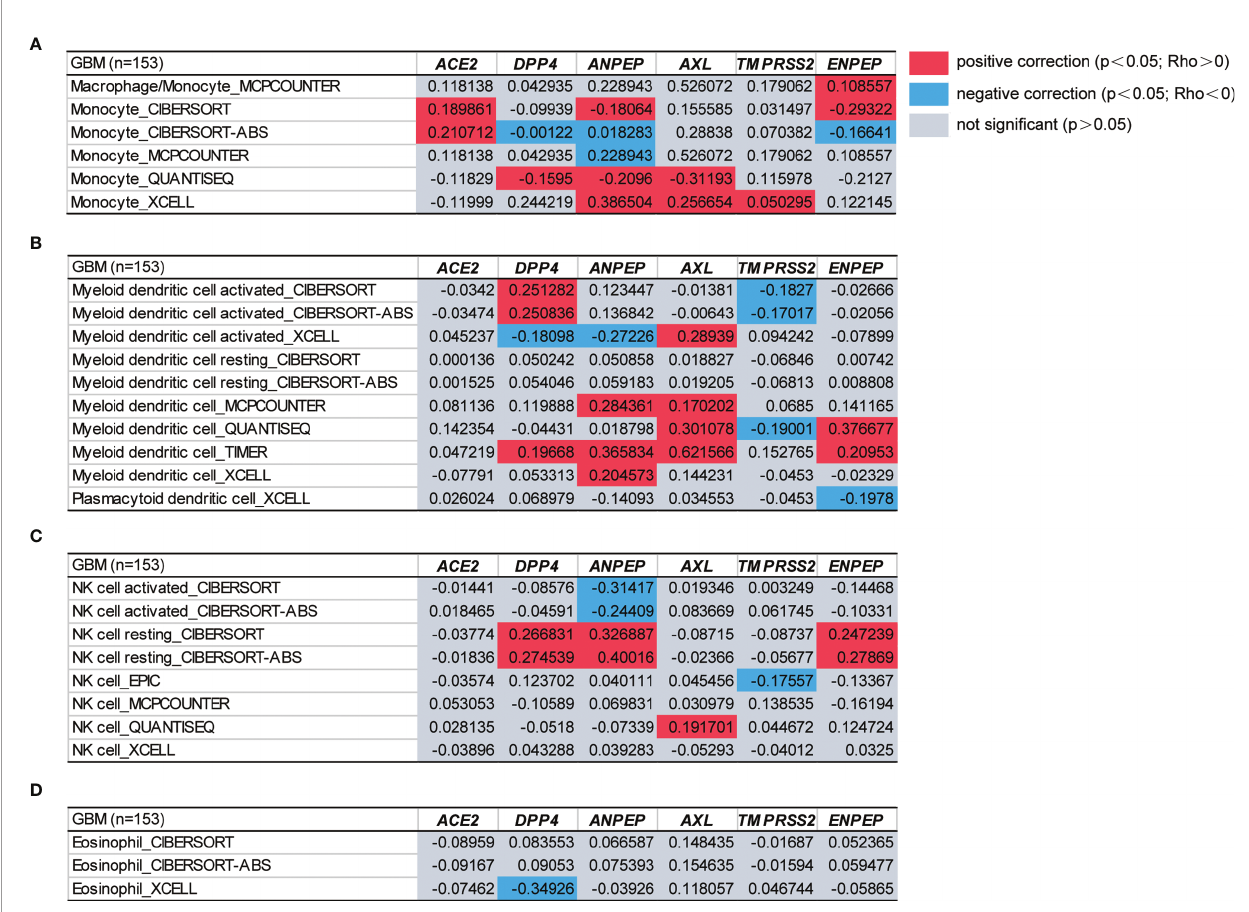
FIGURE 4 | The functional heatmap table of the correlation between coronavirus receptor expressions and immune in fi ltration levels of different cell types in GBM by TIMER2.0. (A) Monocyte. (B) DCs. (C) NK cell. (D) Eosinophil. n = 153. GBM,